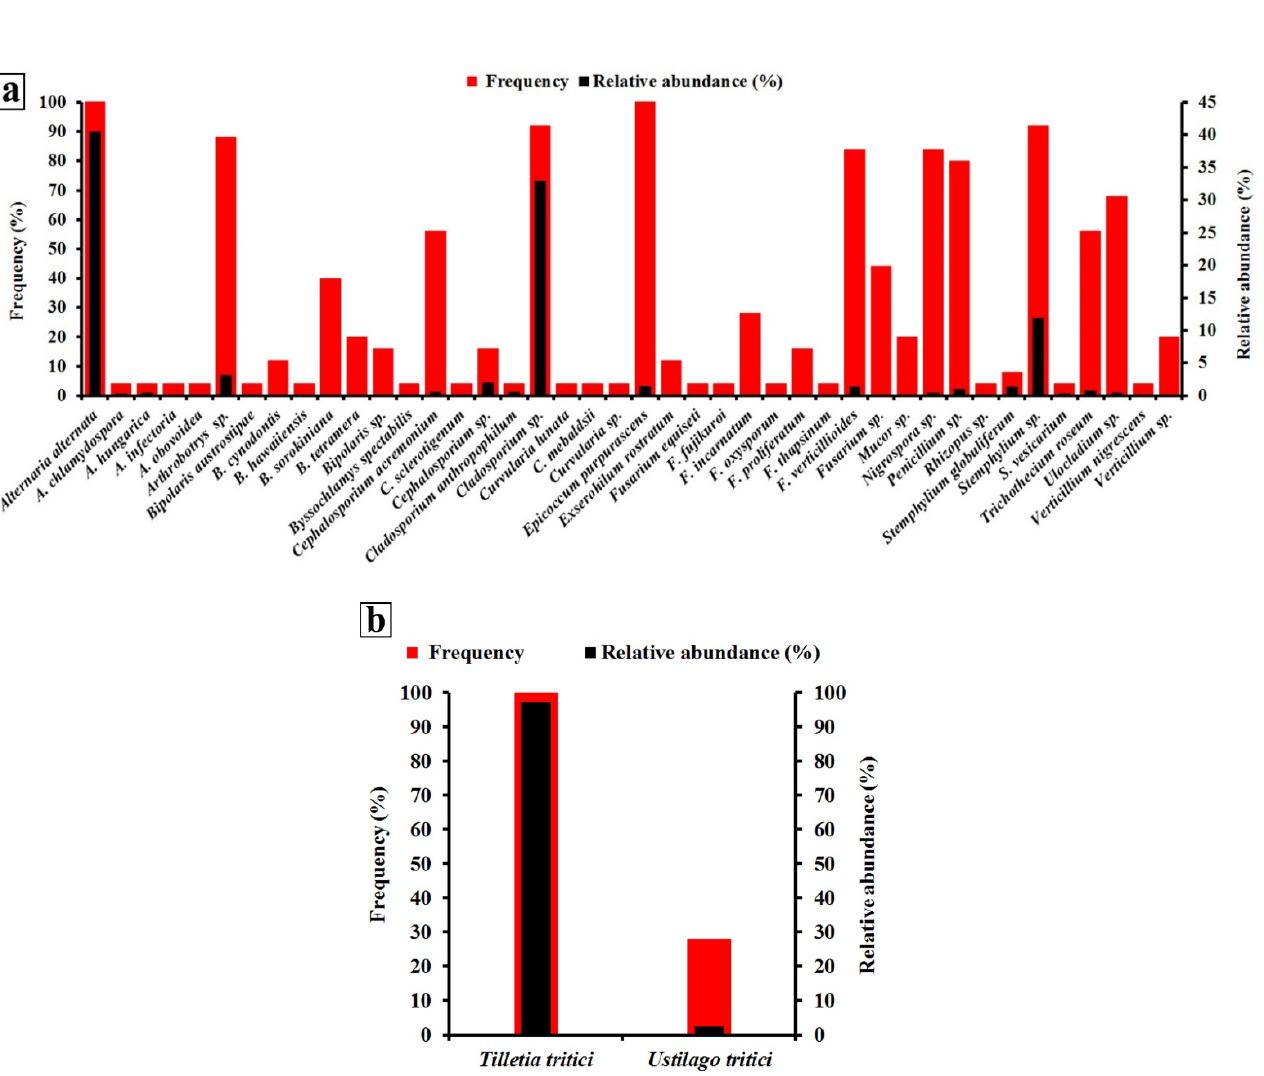
Figure 2. Frequency (%) and relative abundance (%) of wheat seed-borne fungus species detected with the deep-freezing blotter method ( a ) and two wheat smut fungi detected using the washing test for T. tritici and embryo count test for U. tritici ( b ) aggregated across all 25 wheat-growing governorates of Egypt.